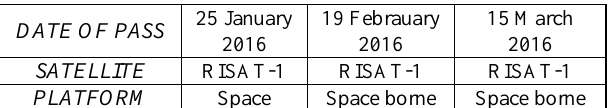
Table 1. Specifications of SAR data and sensor parameters used in this